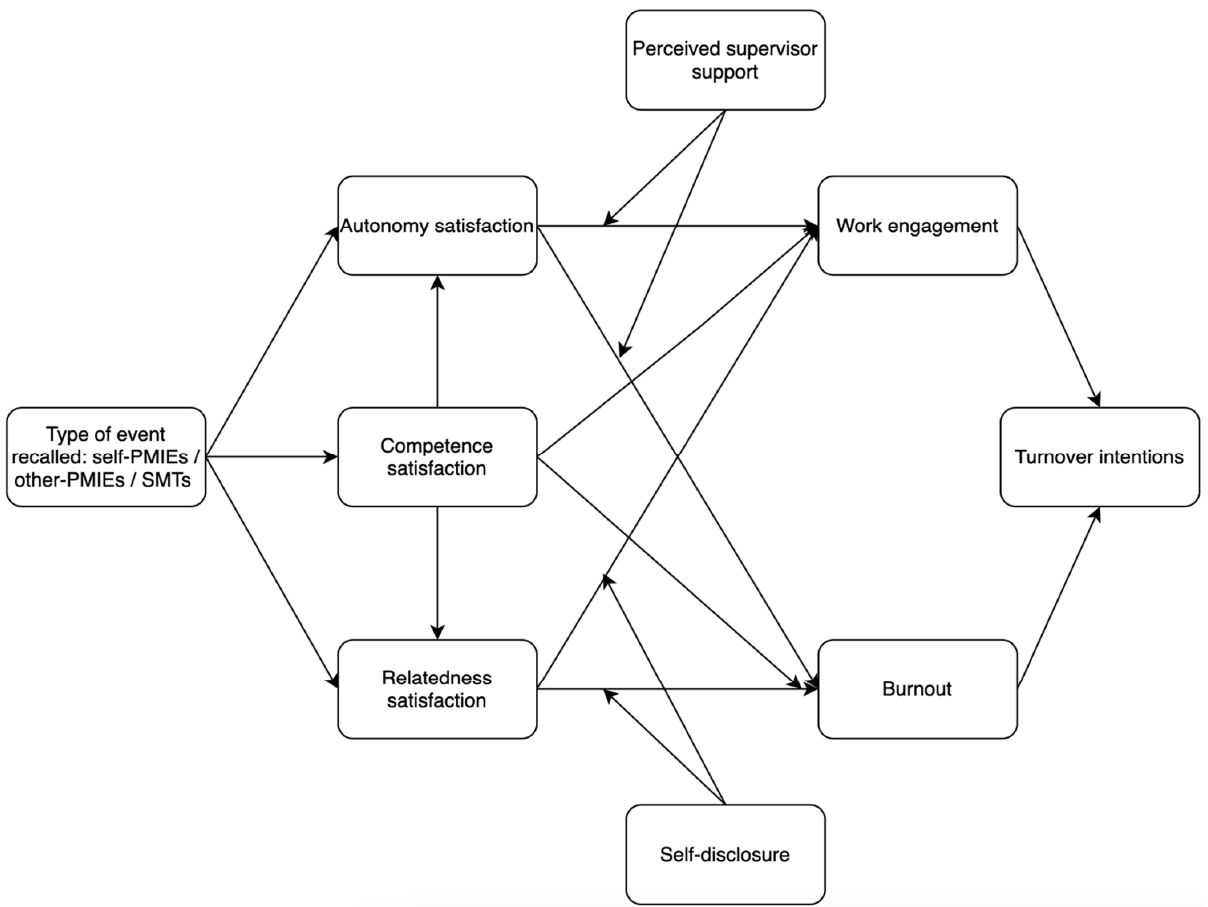
Figure 1. Conceptual